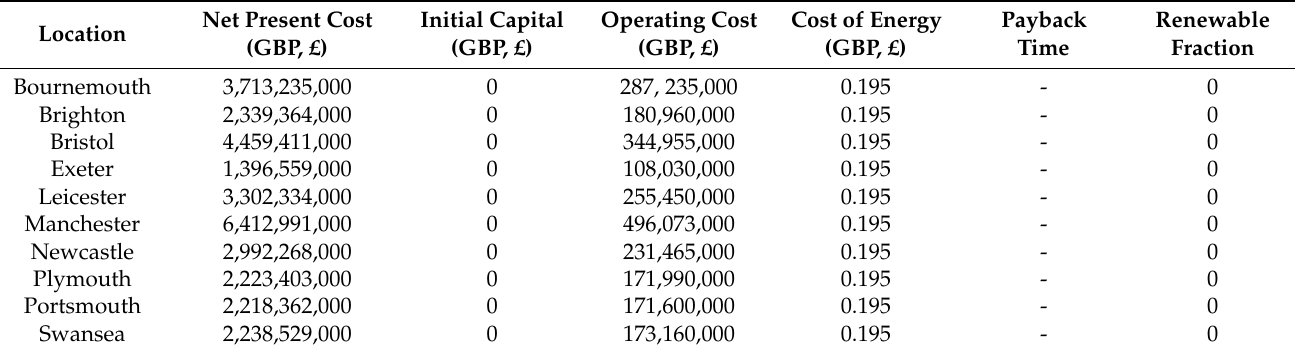
Table 10. Base system data.